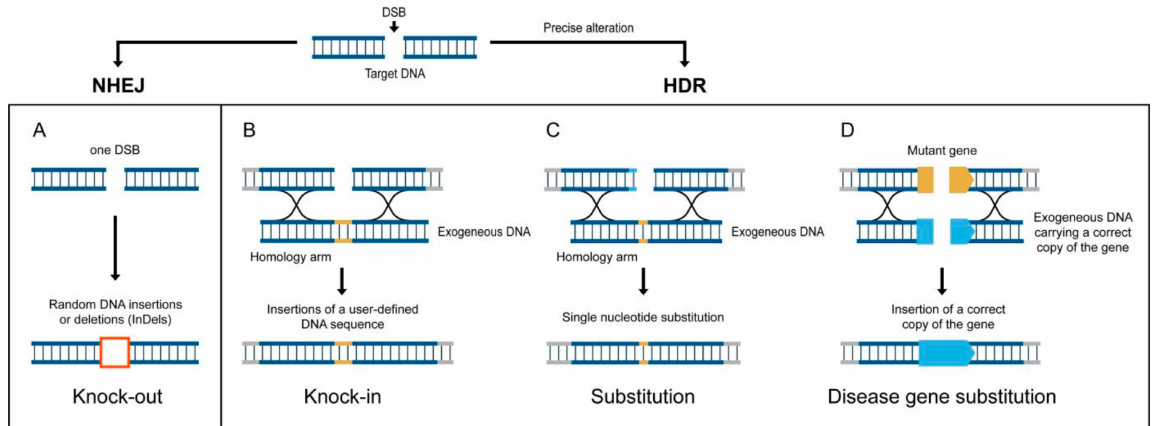
Figure 1. Genome-editing schemes with site-specific DNA nucleases. Double-stranded breaks (DSBs) induced by a nuclease (e.g., CRISPR/Cas9) at a specific site can be repaired by non-homologous end joining (NHEJ) or homology-directed recombination (HDR). ( A ) Repair by NHEJ usually results in the insertion or deletion of random base pairs causing gene knockout. ( B ) HDR with a donor DNA template with homologous arms can be exploited to achieve gene insertion and deletion, ( C ) to modify a gene by introducing precise nucleotide substitutions, and ( D ) inserting a correct gene copy instead of the mutant gene. DSB = double-stranded